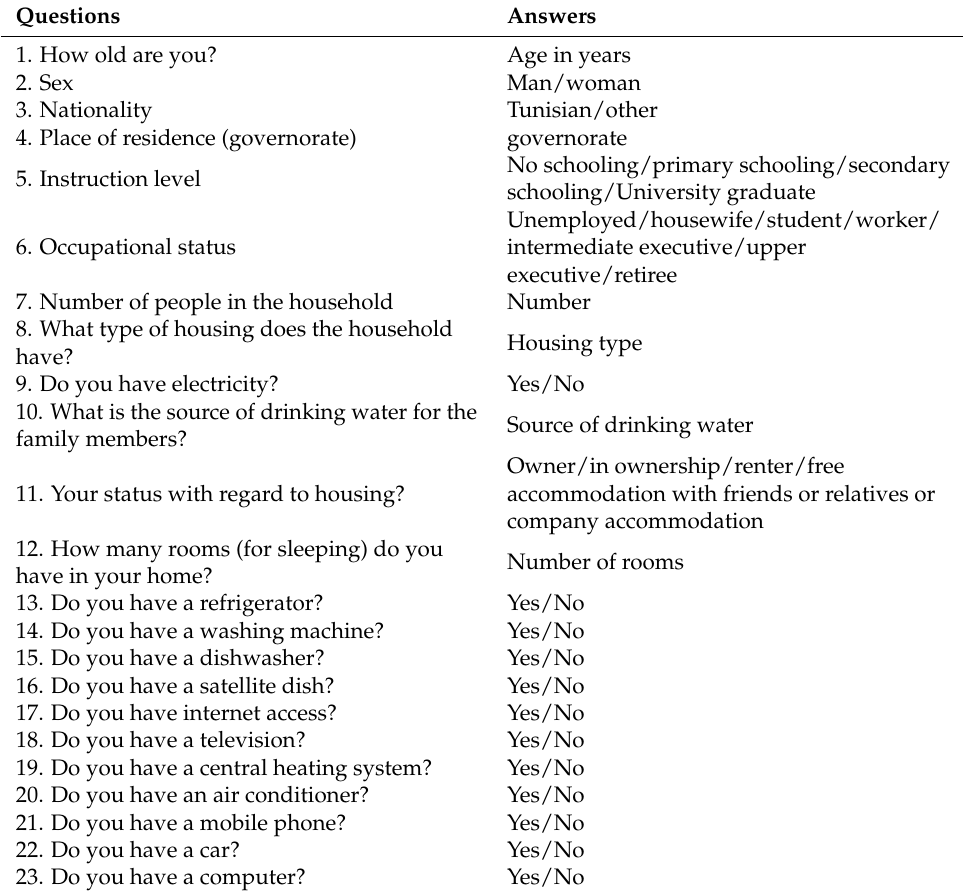
Table A1. Sociodemographic and economic data.